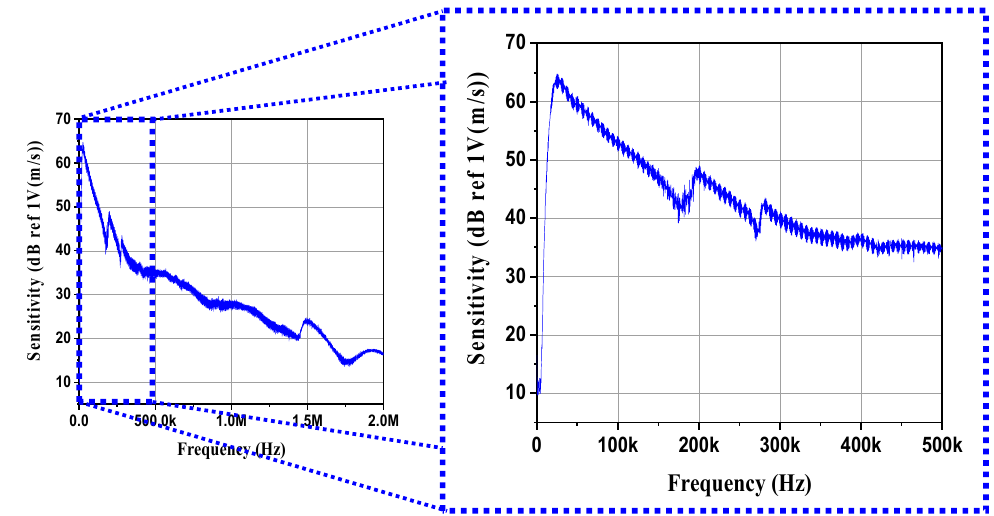
Figure 11. Sensitivity of the AE sensor.